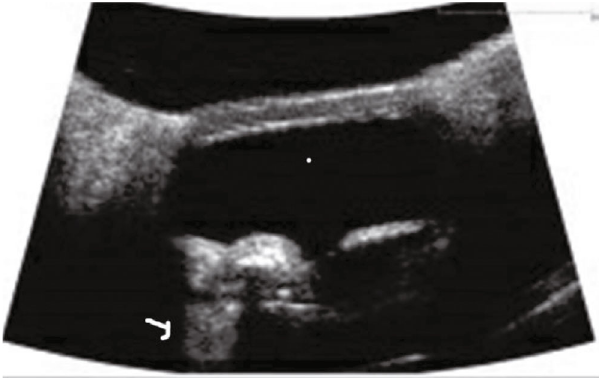
Figure 2: UBM image of the patient with hyperre fl ectivity in the ciliary body adjacent to the supraciliary space with a comet tail artifact (white arrow). It could be due to implant migration anteriorly and fi brous